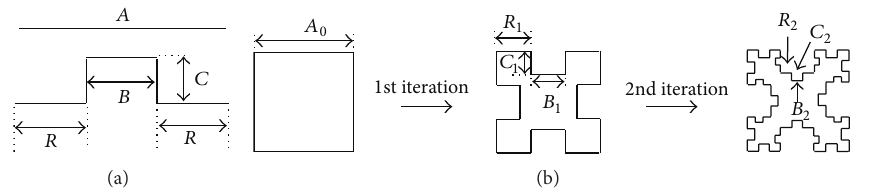
Figure 2: (a) The Minkowski fractal operator and (b) the first and second Minkowski fractal iterations of a square patch antenna.